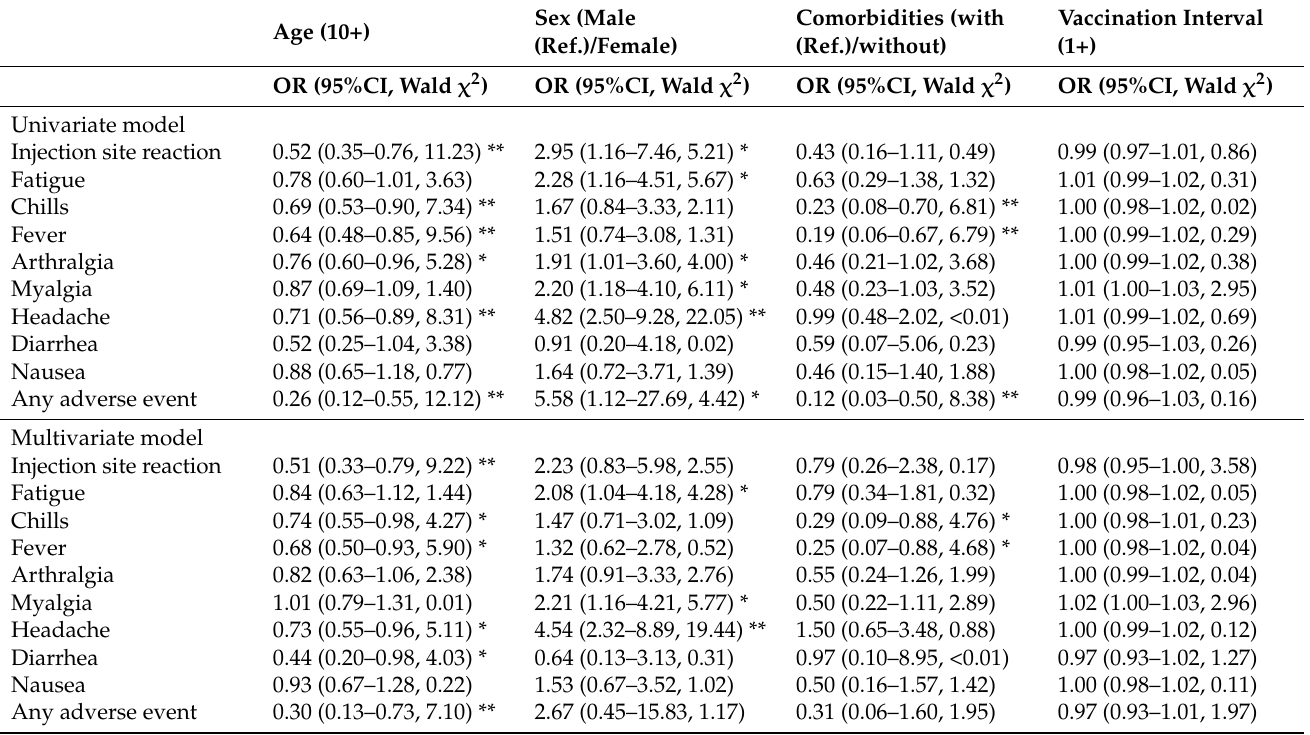
Table 5. Influence of age, sex, comorbidities, and vaccination interval on the presence of adverse reactions after the third dose of BNT162b2